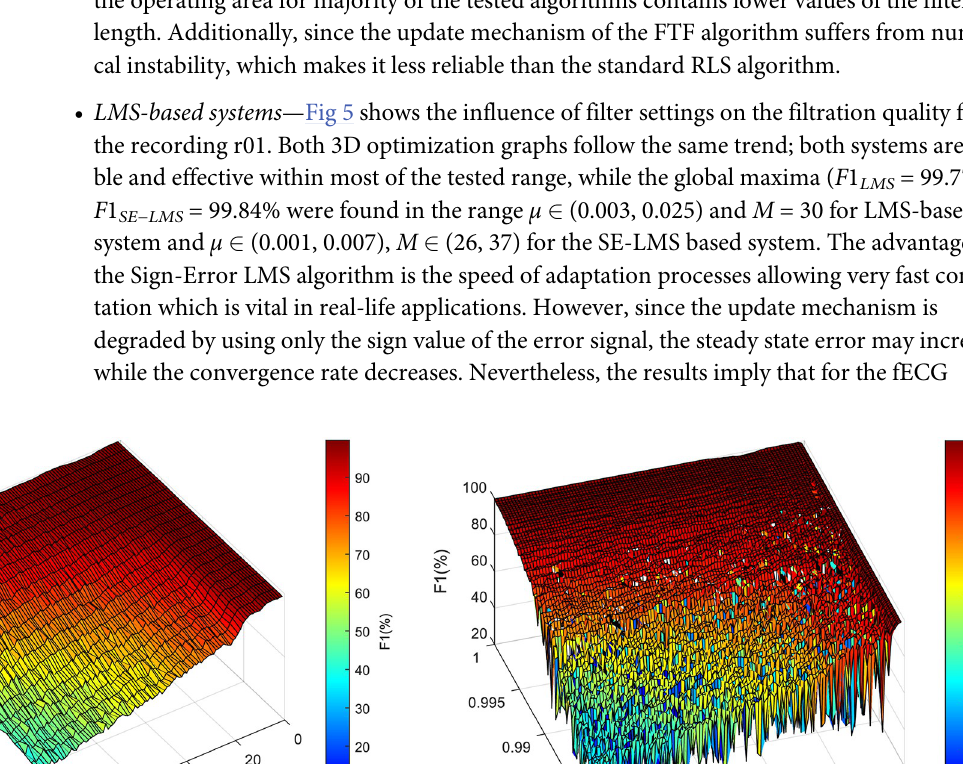
PLOS ONE | https://doi.org/10.1371/journal.pone.0266807 April 11,